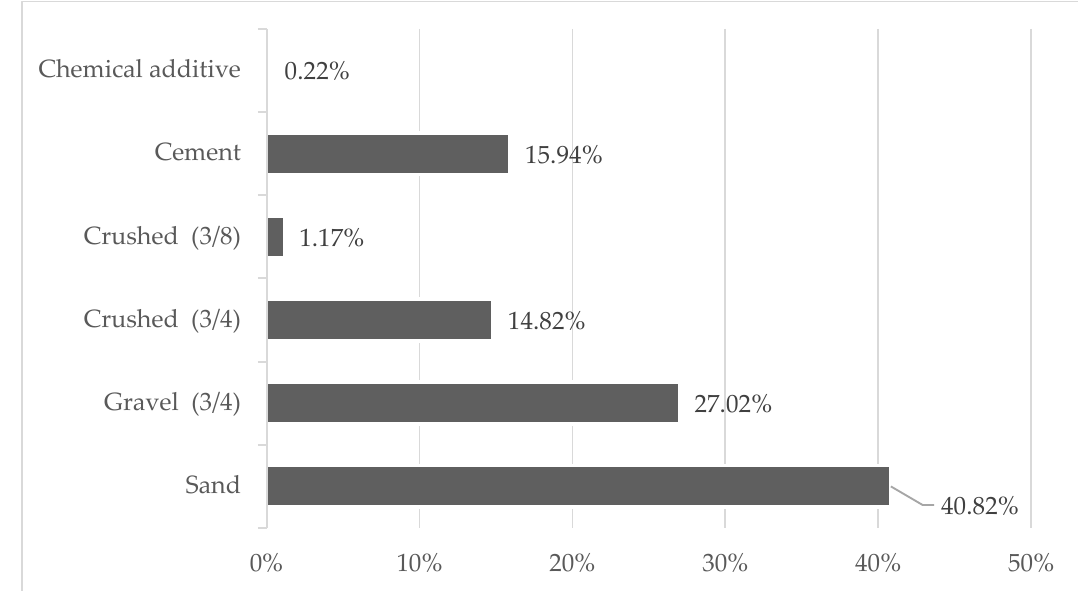
Figure 2. Quantity of each raw material entered during a year in relation to the total.